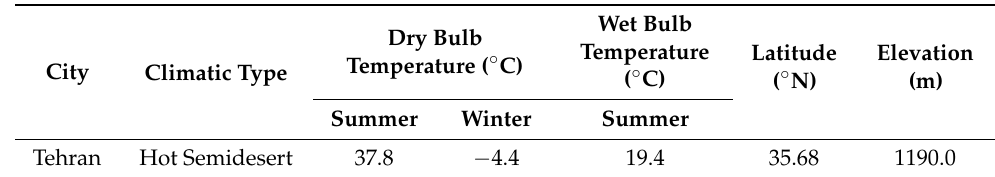
Table 3. Climatic properties of Tehran (reproduced with permission from Abbasi et al., Applied Thermal Engineering; published by Elsevier, 2018 [29]).